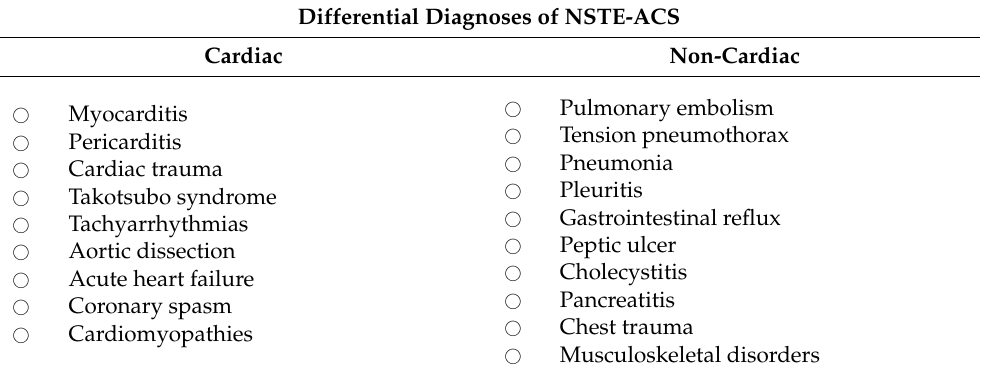
Table 1. A list of the most common clinical conditions to be considered in diagnostics procedures in suspected